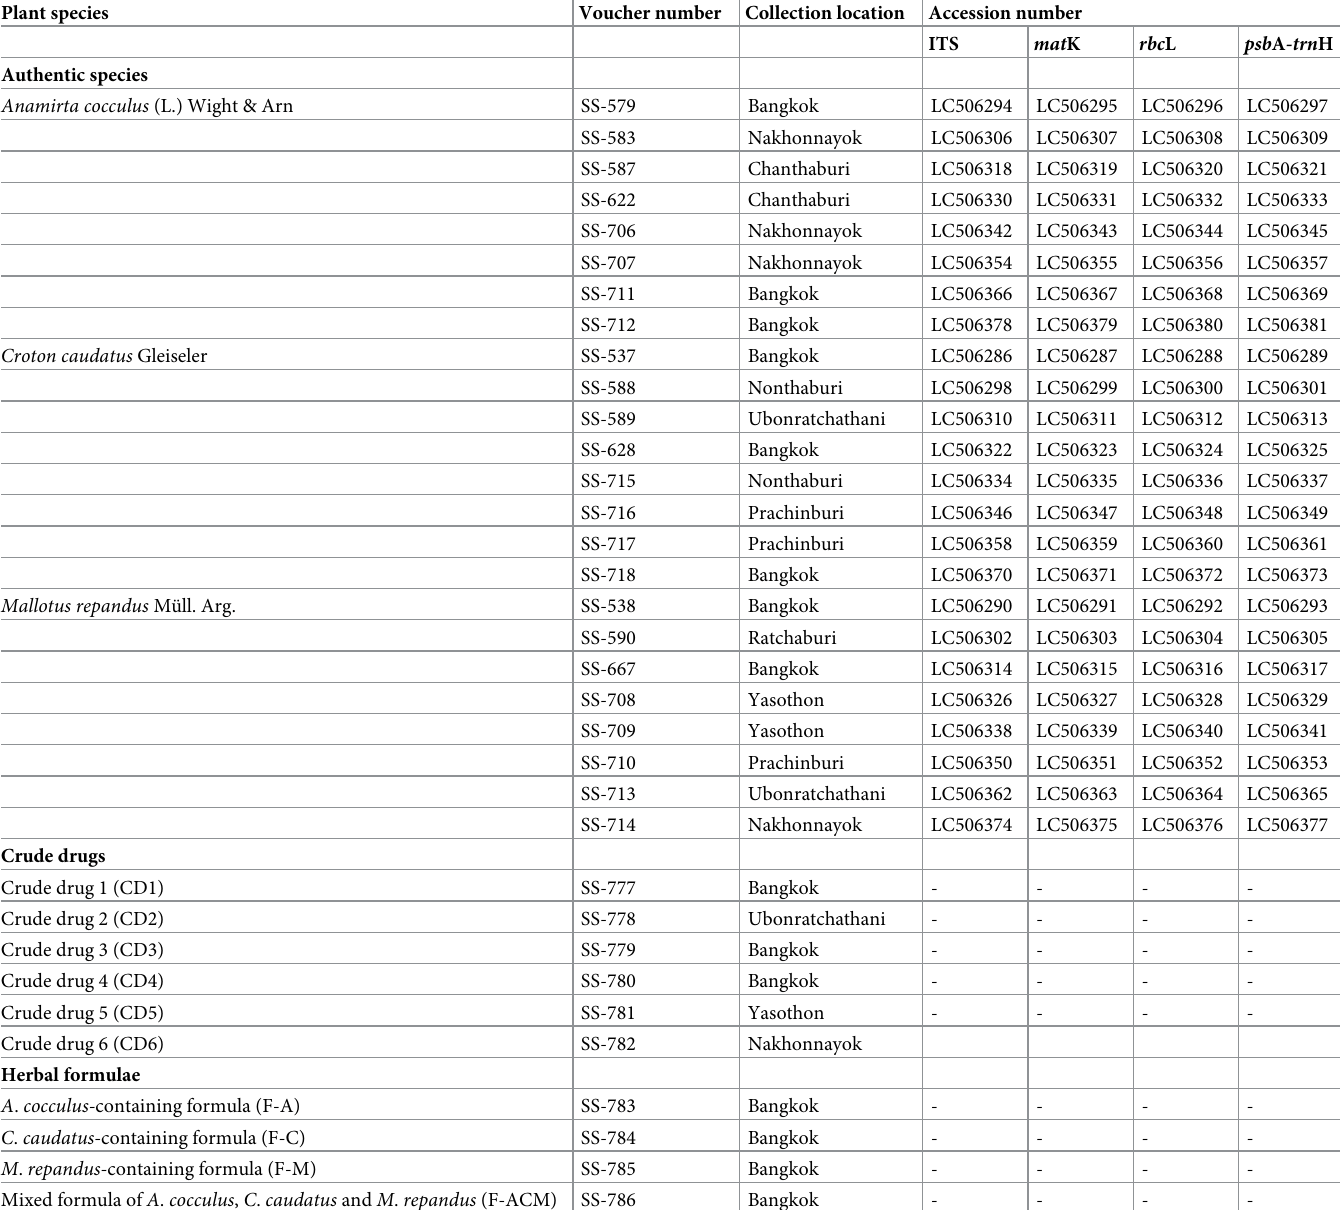
Table 1. Samples used in this study along with their DNA barcode locus accession numbers in GenBank. Crude drugs claiming to be Kho-Khlan purchased from local markets and laboratory-made formulae are listed. Plant species Voucher number Collection location Accession